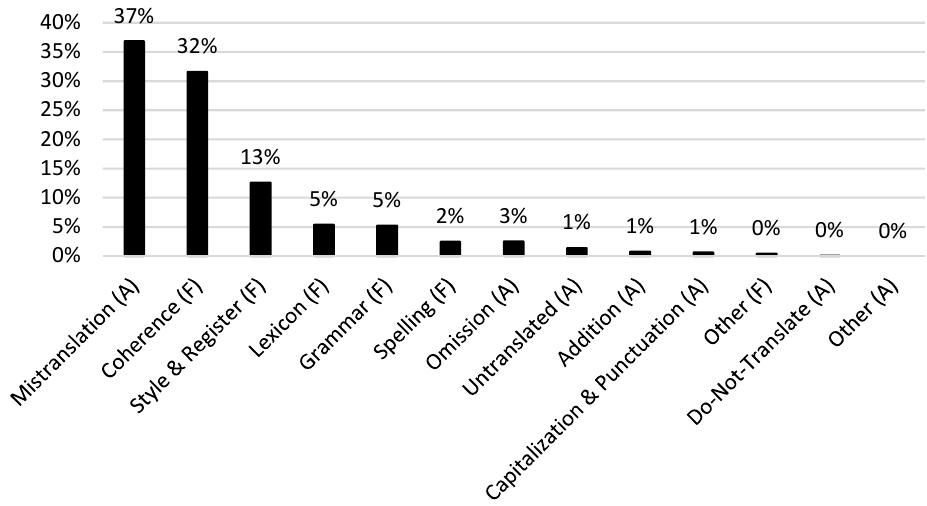
A - Accuracy, F - Fluency Figure 7. Frequency distributions of error types expressed as percentage of all errors (from all four novels and both NMT